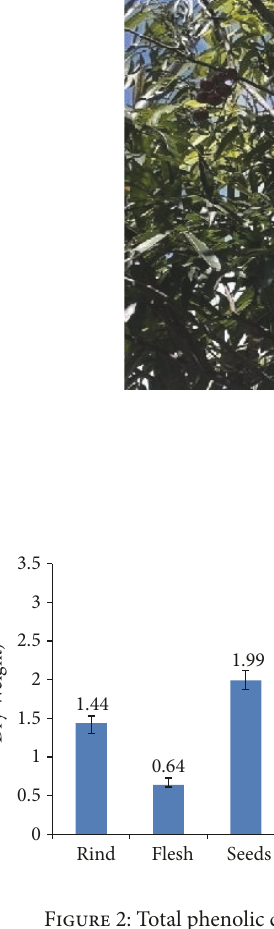
Figure 2: Total phenolic content of L. alata